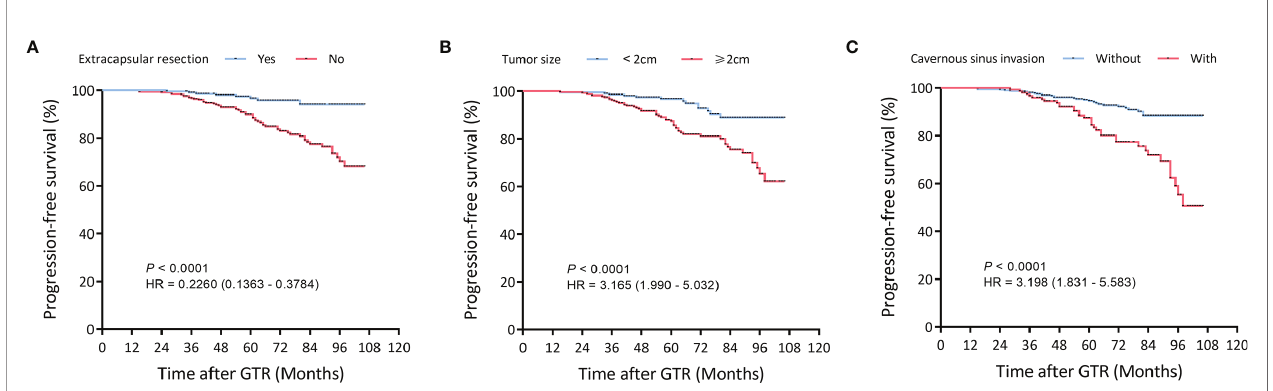
FIGURE 4 | Kaplan – Meier survival curves of fi ltered risk factors in the training cohort. (A) Kaplan – Meier survival curves of tumor size. (B) Kaplan – Meier survival curves of pseudocapsule-based extracapsular resection (ER). (C) Kaplan – Meier survival curves of cavernous sinus invasion (CSI). GTR,